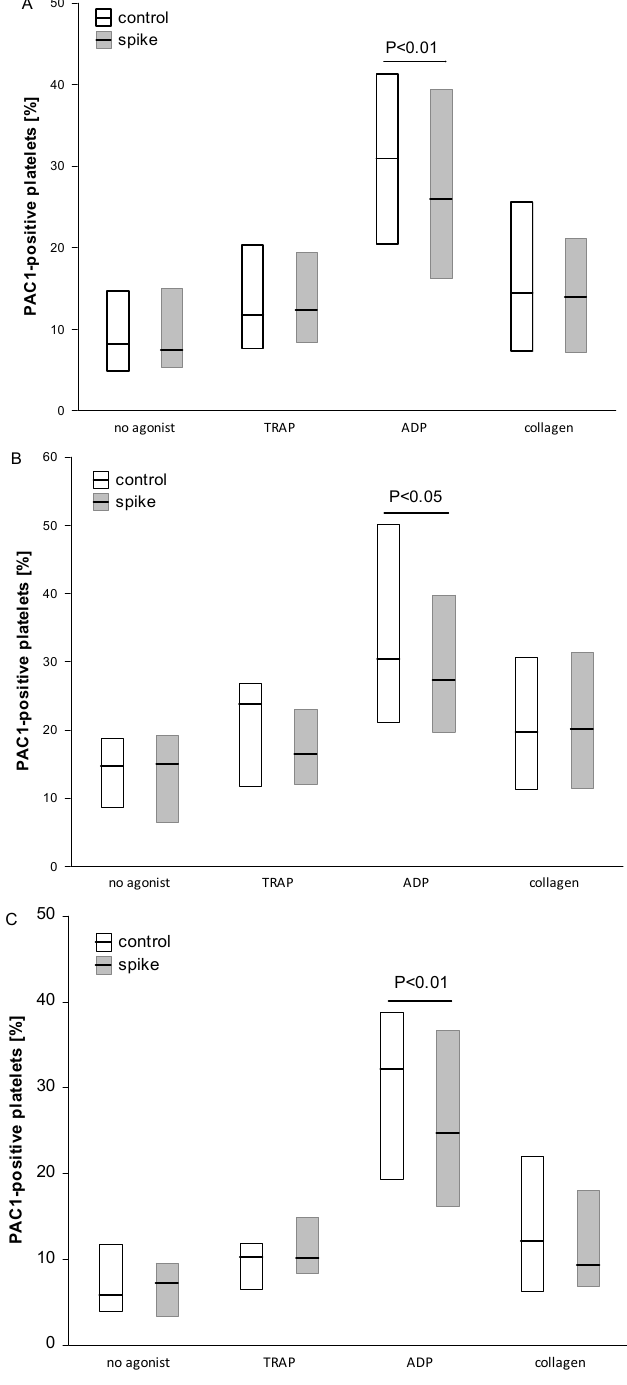
Figure 4. Percent fraction of platelets positive with active fibrinogen receptors (PAC1 binding) in the presence of spike protein. Data are shown as median and interquartile range (Q1; Q3). The analysis was performed in all participant groups, n = 31 ( A ), in the High Ab-group, n = 13 ( B ), and in the Low Ab-group, n = 18 ( C ). A significant reduction in the presence of spike protein was observed for ADP-stimulated platelets irrespective of Ab concentration ( p < 0.05). The statistical significance of the differences between control vs. spike sample was estimated with the bootstrap-boosted paired Student’s t -test.